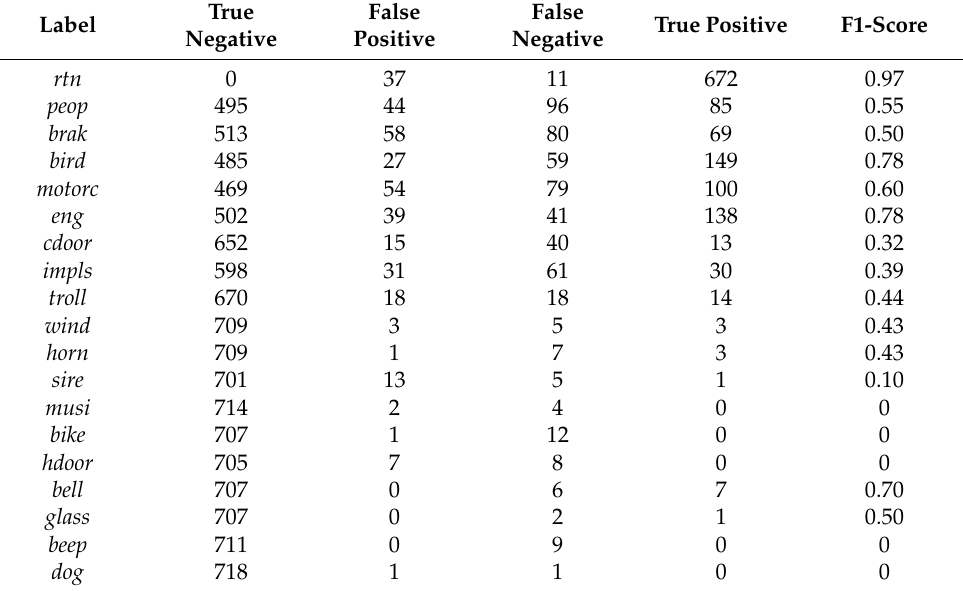
Table 6. Evaluation metrics of the system when combining the outputs of 4 local nodes by using the XGBoost